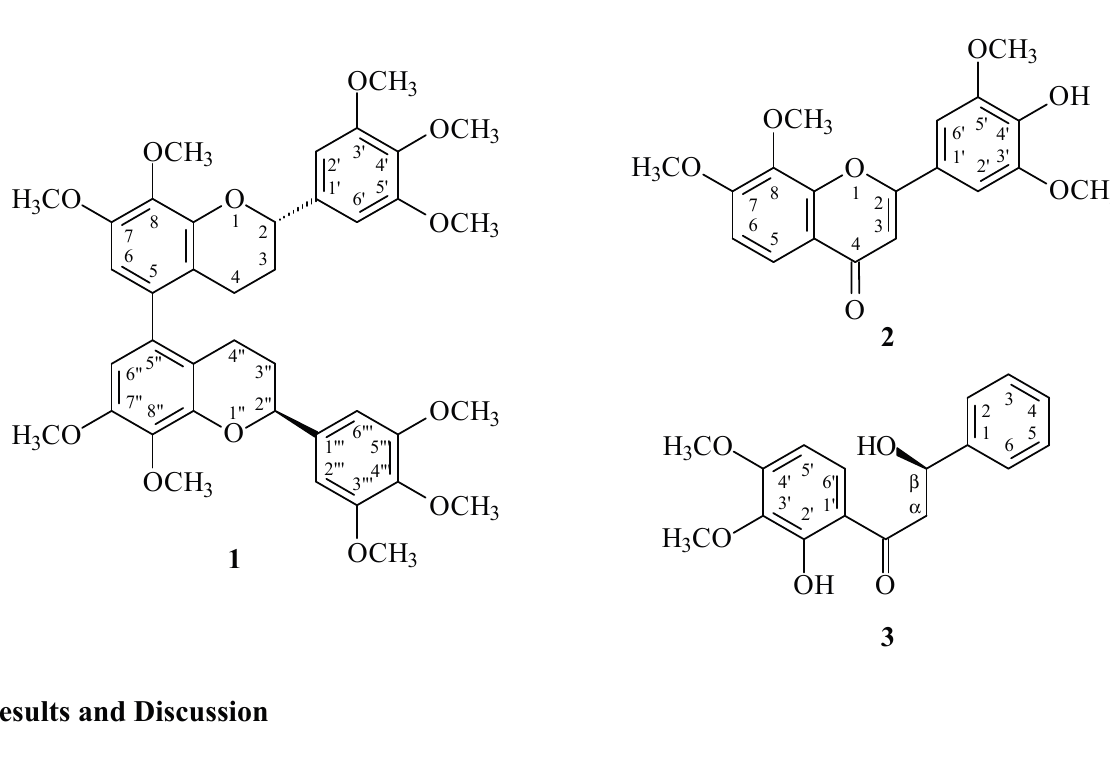
Figure 1. The chemical structures of new compounds 1 – 3 isolated from M. calabura